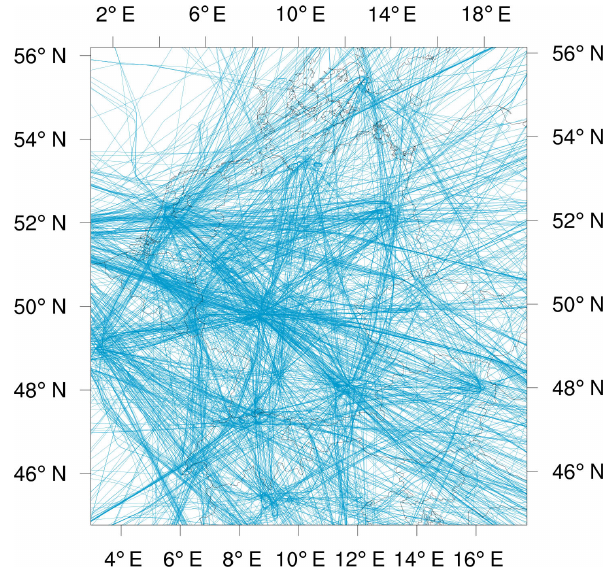
Figure 2. Flight trajectories for the simulated domain derived from ADS-B data (08:00UTC–16:00UTC, 3 December 2013). Each tra- jectory is plotted as a faint dashed line. Seemingly solid or thick lines are indicative of multiple overlaid